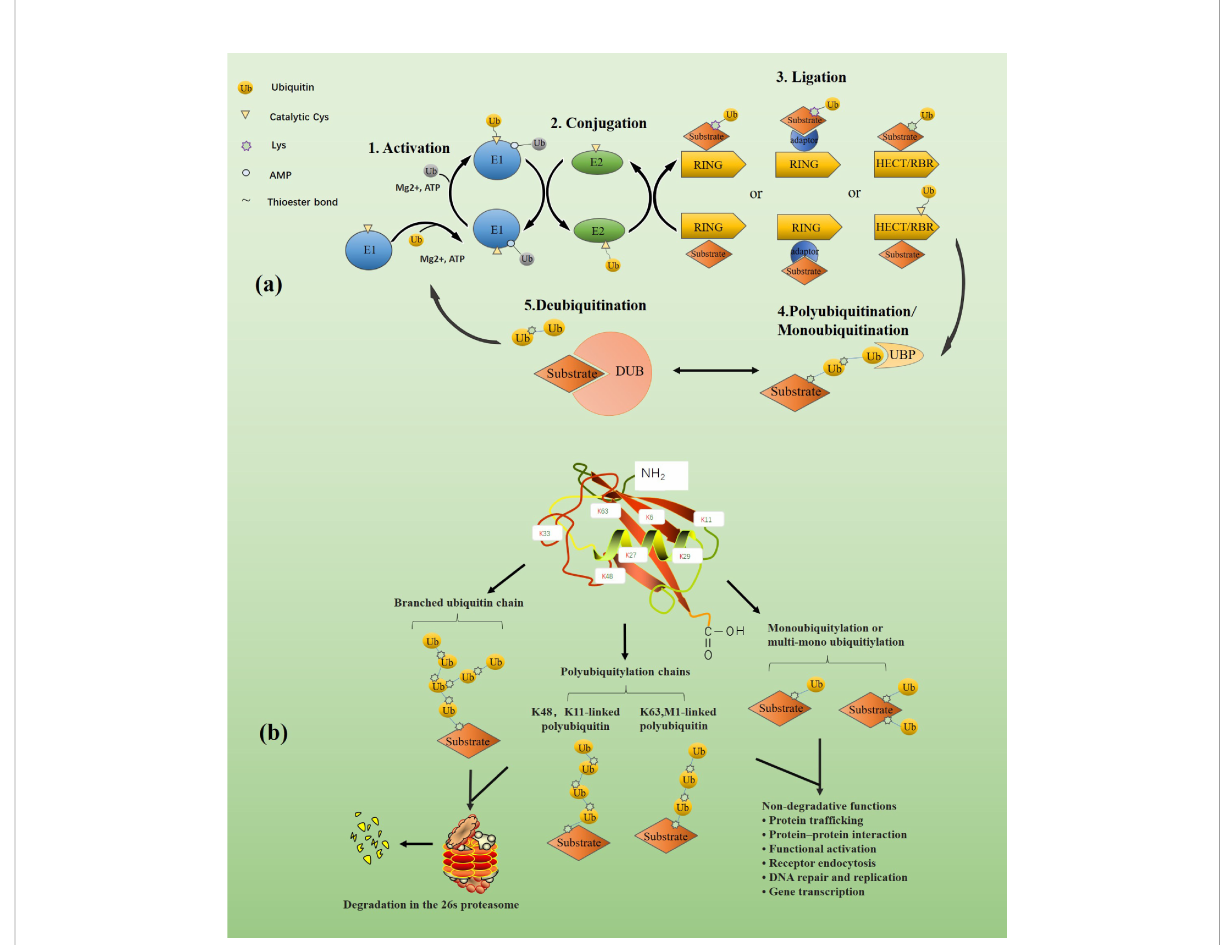
FIGURE 1 (A) The dynamic balance between ubiquitination and de-ubiquitination. First, in the ATP energy supply and the presence of magnesium ions, E1 (blue) activates the ubiquitin by forming a covalent thioester bond through the cysteine at its catalytic site and the diglycine motif at the carboxyl end of ubiquitin (shown in yellow). The rest of ubiquitin (shown in gray) is non-covalently bound to the adenylation domain of E1 through its AMP-modi fi ed carboxyl terminal. The activated ubiquitin is transferred to the cysteine of the catalytic site of E2 through the diglycine motif of E1 to form the E2~ubiquitin thioester complex. Finally, E3 and E2-ubiquitin bind and jointly recognize and bind to the substrate. Depending on the type of E3, the way ubiquitin binds to the substrate is also different. For example, RING E3 ligase directly promotes the transfer of ubiquitin from E2 to the substrate. In contrast, HECT or RBR E3 ligase forms a thioester intermediate with ubiquitin before the transfer and then promotes the binding of ubiquitin to the substrate. Monoubiquitin chains or polyubiquitin chains are formed on substrates under the catalysis of ubiquitin-speci fi c protease. Moreover, DUBs can deconjugate ubiquitin chains from ubiquitinated substrates, thereby reversing the ubiquitination process and regenerating free ubiquitin molecules. The fi gure is referenced from Figure 1 of the ubiquitin system: a critical regulator of innate immunity and pathogen-host interactions (1). (B) The classi fi cation of ubiquitin chains and the functions of various ubiquitin chains. Different types of ubiquitination modi fi cations lead to different physiological activities of substrates. Branched, K48-, and K11- linked ubiquitin chains typically target substrates for degradation in the 26s proteasome, while K63- and M1-linked ubiquitin chains and mono- or multi-mono-ubiquitin chains are mainly involved in non-proteolytic events, such as signaling cascades, protein interactions. The fi gure is referenced from Figure 1 of Ubiquitin-binding domains - from structures to functions